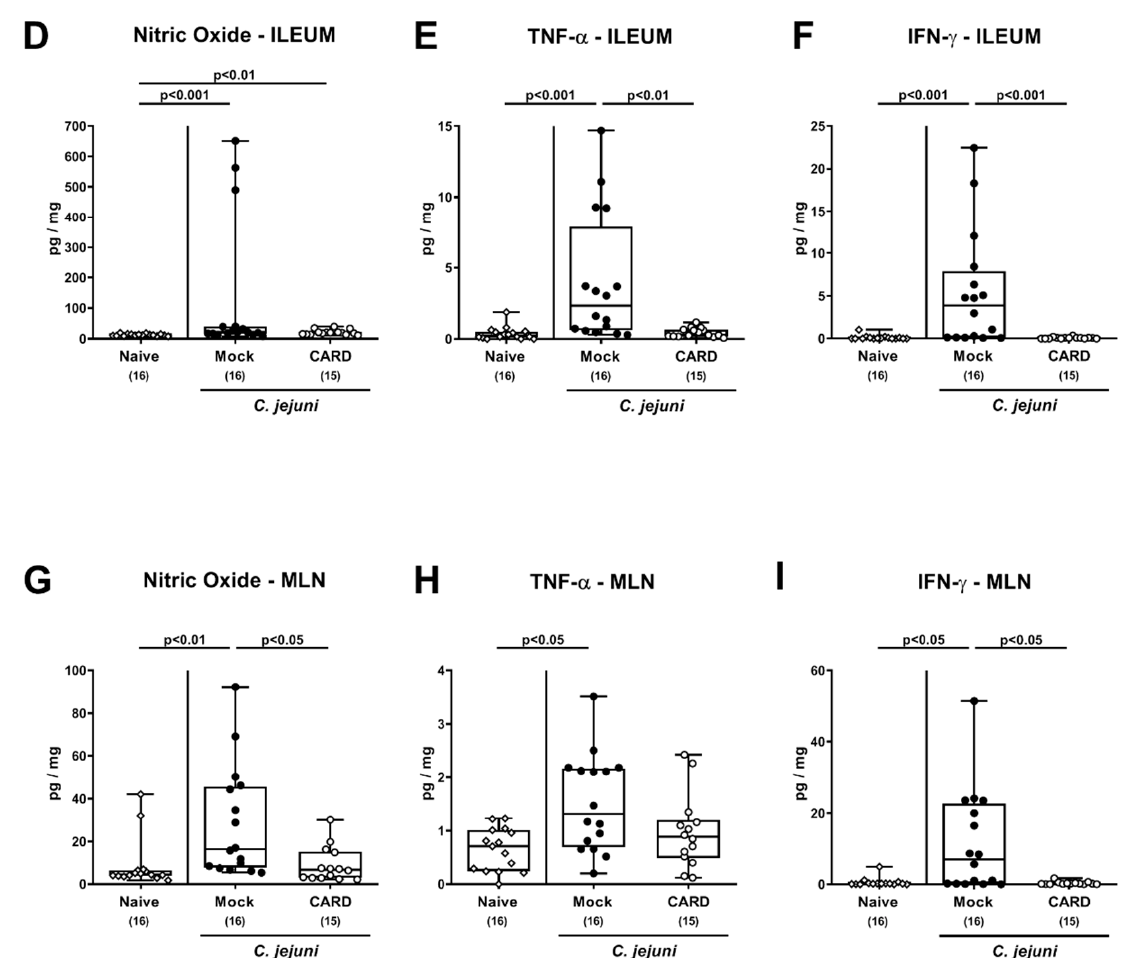
Figure 6. Intestinal pro-inflammatory mediator secretion following oral cardamom essential oil application to C. jejuni - infected microbiota-depleted IL-10 − / − mice. Microbiota-depleted IL-10 − / − mice were infected with C. jejuni strain 81–176 on days 0 and 1 by gavage and perorally challenged with cardamom essential oil (CARD; white circles) via the drinking water starting on day 2 post-infection, whereas mock control mice received vehicle (black circles). On day 6 post-infection, ( A , D , G ) nitric oxide, ( B , E , H ) TNF- α , and ( C , F , I ) IFN- γ concentrations were measured in ex vivo biopsies derived from the ( A – C ) colon, ( D – F ) ileum, and ( G – I ) mesenteric lymph nodes (MLN). Naive mice (open diamonds) served as untreated and uninfected controls. The box plots indicating the 75th and the 25th percentiles of the median (black bar within box), the total range, the levels of significance ( p values) as calculated with the Kruskal–Wallis test and Dunn’s post-correction, and the number of analyzed mice (in parentheses) are shown. Data were pooled from four independent experiments.